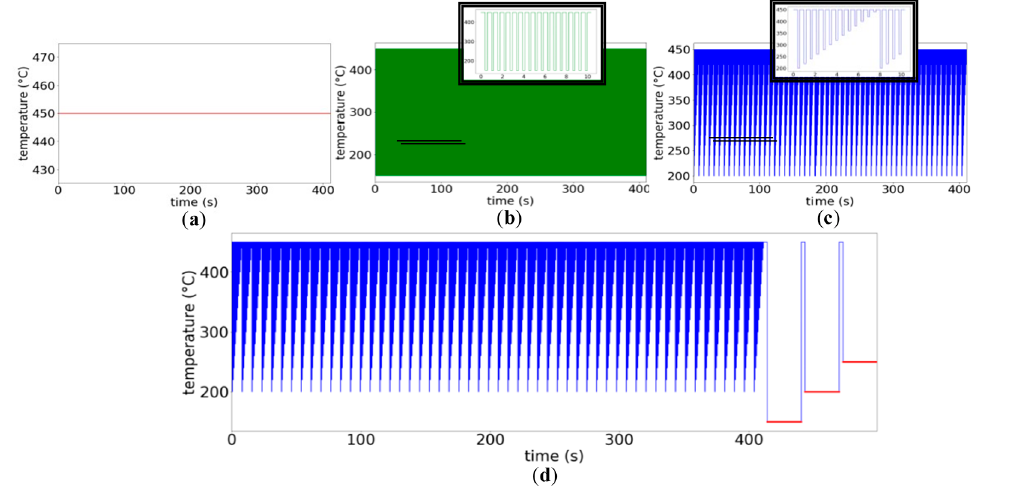
Figure 1. Temperature profiles for: ( a ) Exp1 (i); ( b ) Exp1 (ii); ( c ) Exp1 (iii); ( d )